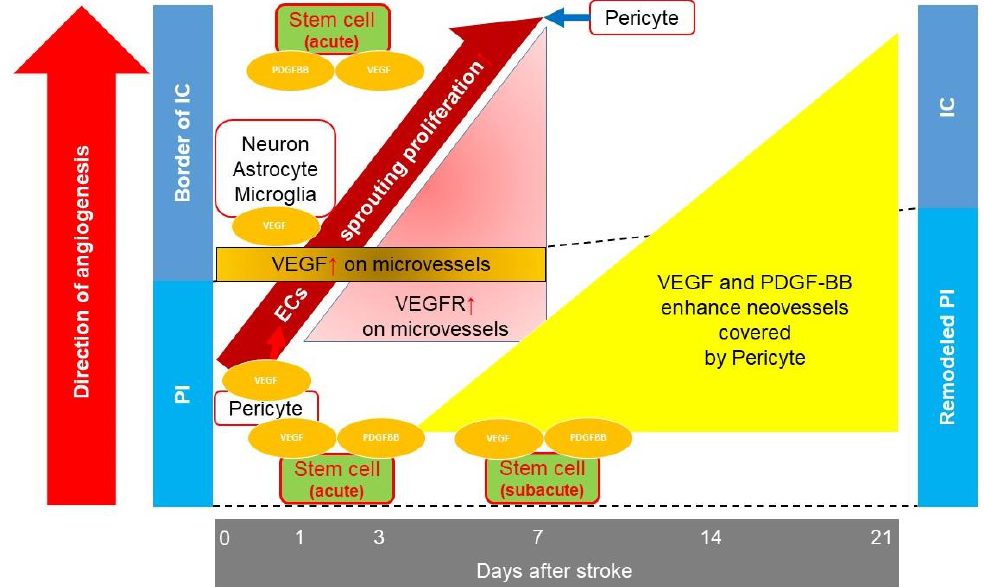
Figure 1. Summary of angiogenesis after intraarterial (IA) stem cell transplantation in acute and subacute phases post ischemic stroke. At the border of the infarct core (IC), within 24 h of ischemic stroke, neurons, astrocytes, and microglia secrete vascular endothelial growth factor (VEGF). The level of VEGF from microvessels increases after ischemic stroke, peaks on day 3, and normalizes until day 7 post ischemic stroke. In the periinfarct area (PI), pericytes secrete VEGF, helping endothelial cells (ECs) to proliferate. The expression of VEGF receptors (VEGFRs) on microvessels increases by day 2 post ischemic stroke, peaks on day 3, and normalizes until day 7. The expression of VEGFR and proliferation of ECs spreads from the PI to the IC. Once there is sufficient angiogenesis, pericytes terminate the sprouting proliferation of ECs. In the subacute phase, VEGF and platelet-derived growth factor-BB (PDGF-BB) enhance mature angiogenesis. In acute phase IA stem cell transplantation, stem cells are widely distributed in the IC and PI. In subacute phase IA stem cell transplantation, stem cells are mainly distributed in the PI. Transplanted stem cells secrete various growth factors, including VEGF and PDGF-BB, to promote angiogenesis. Thus, stem cell transplantation can reduce the infarct volume (red arrow, increase or enhancement; blue arrow, decrease or inhibition).